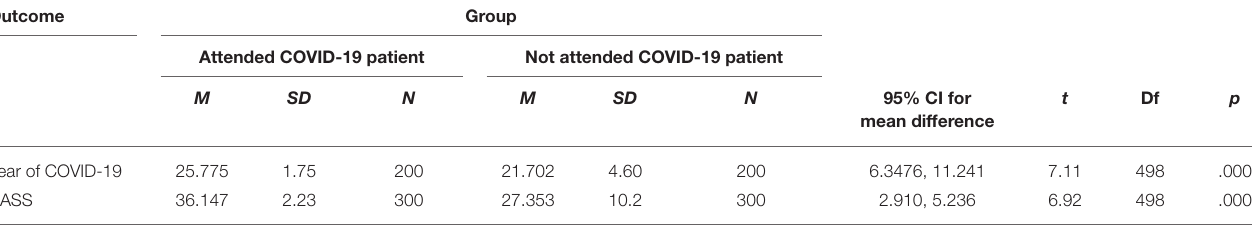
TABLE 7 | Comparison of fear of COVID-19 and emotional distress between nurses who worked and did not work with COVID-19 patients ( N = 500). Outcome Group Attended COVID-19 patient Not attended COVID-19 patient